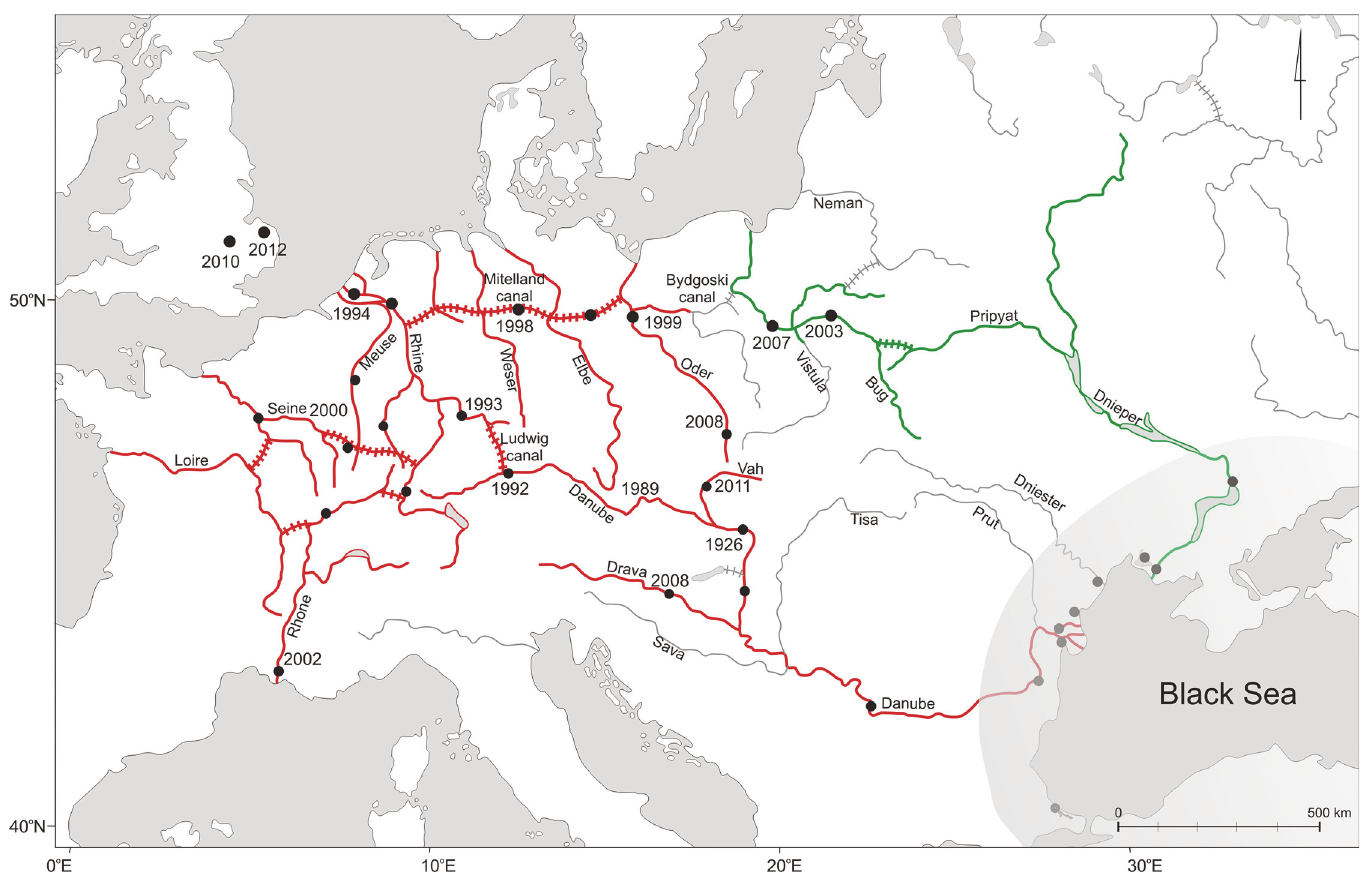
Fig 1. Distribution of Dikerogammarus villosus in its native (N) area in the Black Sea basin (shaded area) and along Eastern (E) and Western (W) routes (R) of invasions in continental Europe as well as in UK. Dashed lines represent canals. The presumed Western Route is indicated in red, Eastern Route in green. Numbers are dates of the first report of D. villosus at these sites. Black dots are sampling sites used in this study.